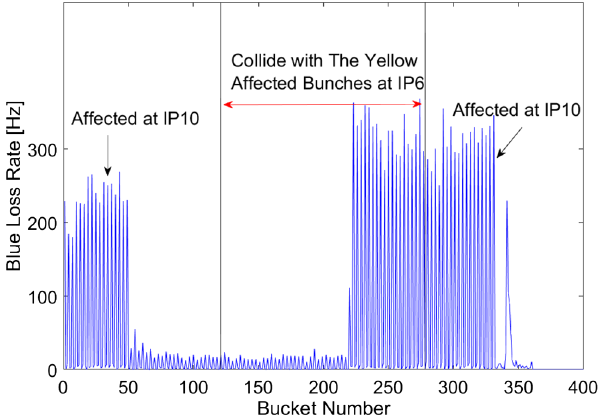
FIG. 14. Blue BBB loss rate affected by the yellow hollow lens in the nth turn excitation mode because of dipole kicks at IP10.